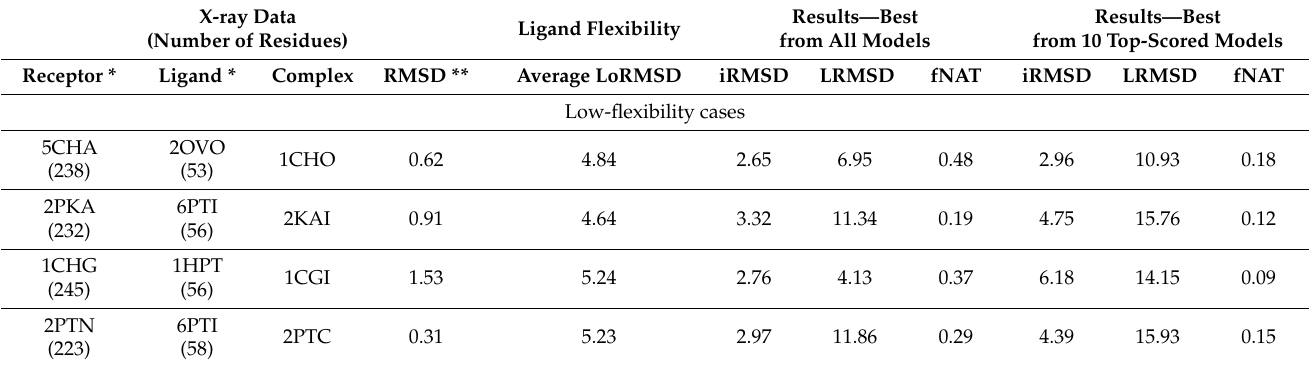
Table 1. Summary of the docking simulations. The table characterizes X-ray data used in the docking, average ligand flexibility, and docking results. The table reports the best accuracy models out from all (10,000) and 10 top-scored models. The metrics definitions are provided in the Methods section. The table divides the presented cases on the three categories: low-flexibility, medium-flexibility and highly flexible cases.